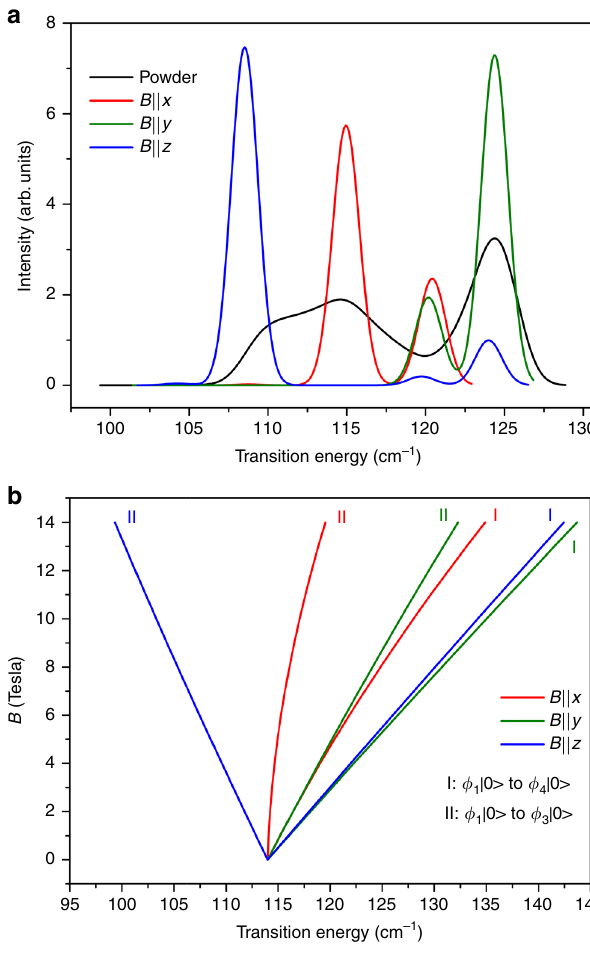
Fig. 7 Simulated inter-KD, magnetic-dipole-allowed transitions and their fi eld dependence. a Simulated inter-KD, magnetic-dipole-allowed transitions for the S = 3/2, spin-only Hamiltonian description of 1 . Single-crystal spectra for fi elds of 5T in the x, y, z directions at 1.7K are shown in red, green and blue. The powder average is given in black. Vibronic coupling was ignored. Spin-Hamiltonian parameters are taken from ref. 15 : D = 57cm − 1 , E / D = 0.31, g x = 2.50, g y = 2.57, g z = 2.40 (corresponding g' -values for ground and excited KDs: g' i (1) = 2.65, 6.95, 1.83; and g' i (2) = 2.34, 1.80, 6.63, respectively). The dominant pairs of left and right lines found for the single-crystal orientations (in blue, green, red) correspond to the dominant ϕ 〉 → ϕ 〉 and ϕ 〉 → ϕ 〉 transitions, respectively. b Field 1 |0 3 |0 1 |0 4 |0 dependence of the inter-KD spectra for fi elds in the x, y, z directions